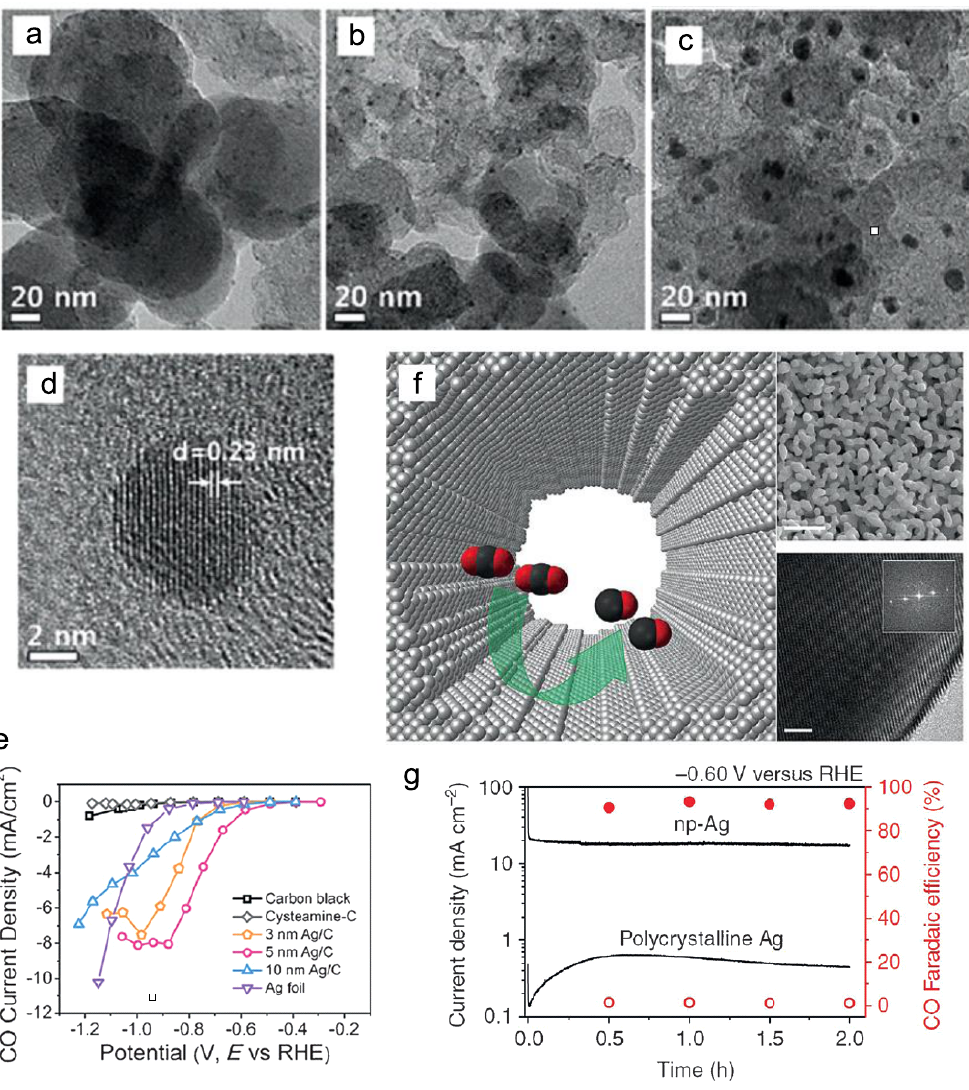
Figure 2. ( a – c ) TEM images of the 3, 5, and 10 nm Ag NPs load on carbon supports; ( d ) High-resolution transmission electron microscope (HR-TEM) image of the 5 nm Ag/C catalyst; ( e ) CO partial current densities of three typical Ag/C catalysts with different NP sizes. Adapted with permission from Ref. [35]. Copyright 2015, American Chemical Society; ( f ) The schematic representation, scanning electron microscope (SEM), and HR-TEM images of a nanoporous silver electrocatalyst with highly curved internal surface (scale bar 500 nm & 2 nm); ( g ) CO 2 reduction activity of nanoporous silver. Adapted with permission from Ref. [37]. Copyright 2014, Nature Publishing Group.